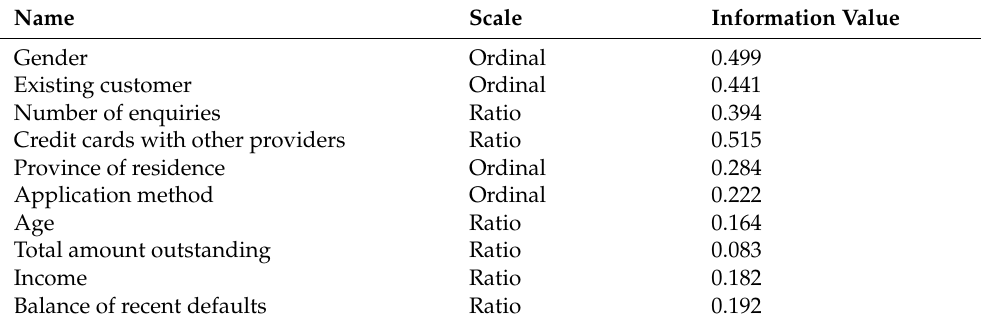
Table 1. The name, measurement scale and information value of the attributes included in the model.